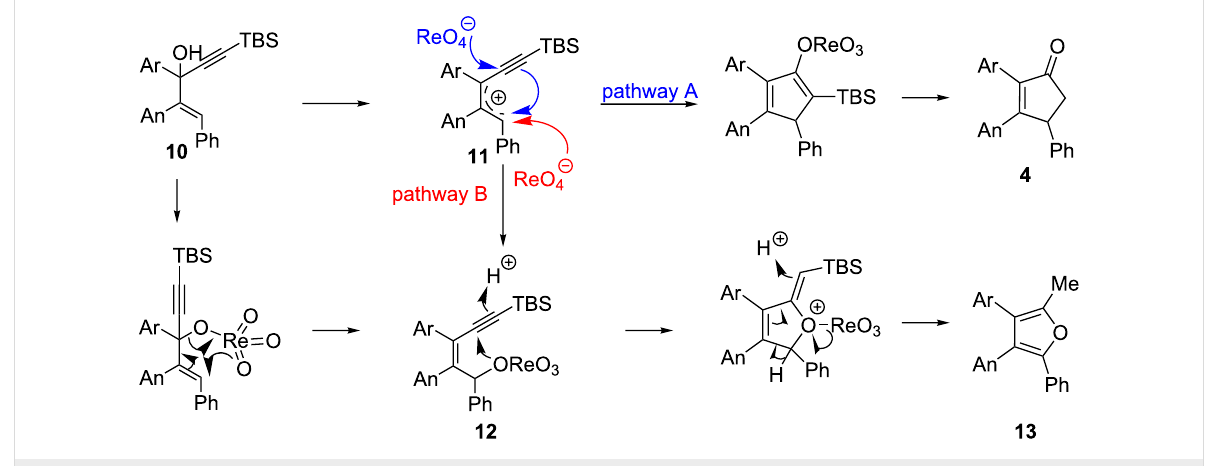
Scheme 4: Postulated mechanism for the formation of cyclopentenone 4 and furan 13 (entry 1, Table 1; An= p -anisyl).